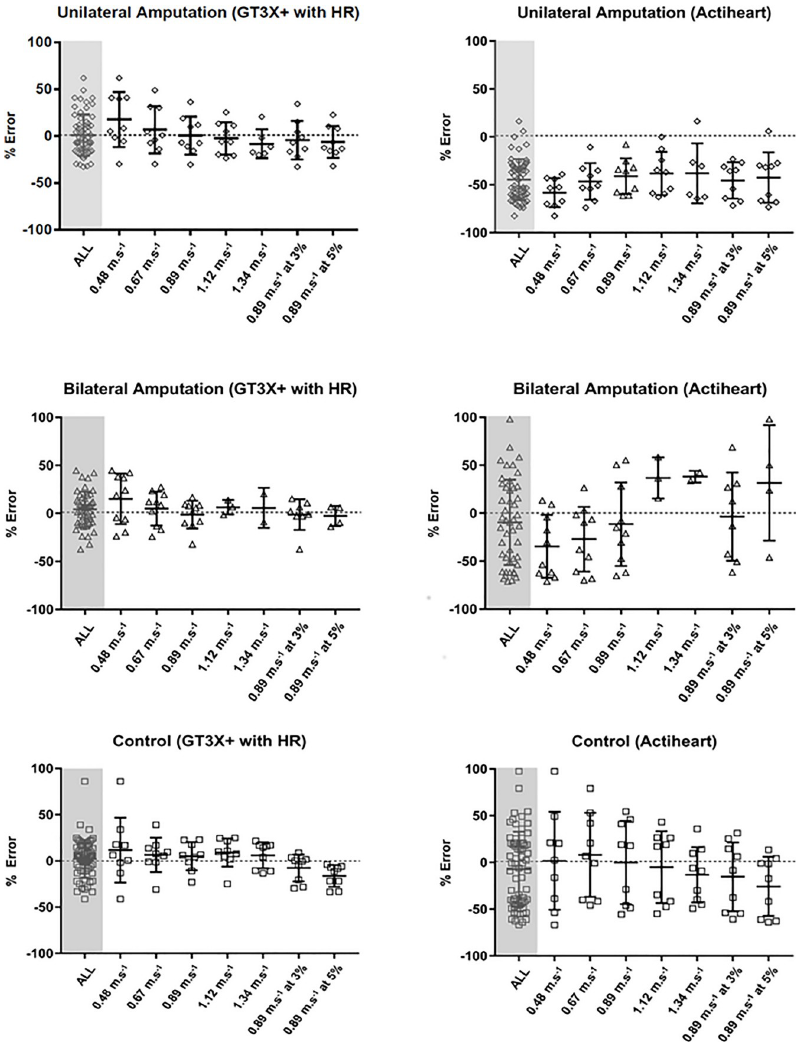
Fig 3. Modified box and whisker plots demonstrating the mean percentage error of estimation relative to criterion for each treadmill activity using GT3X+ with heart rate estimation models (A, C, E), and Actiheart (B, D, F). The plots show the unilateral group (A, B), bilateral group (C, D) and control group (E, F).